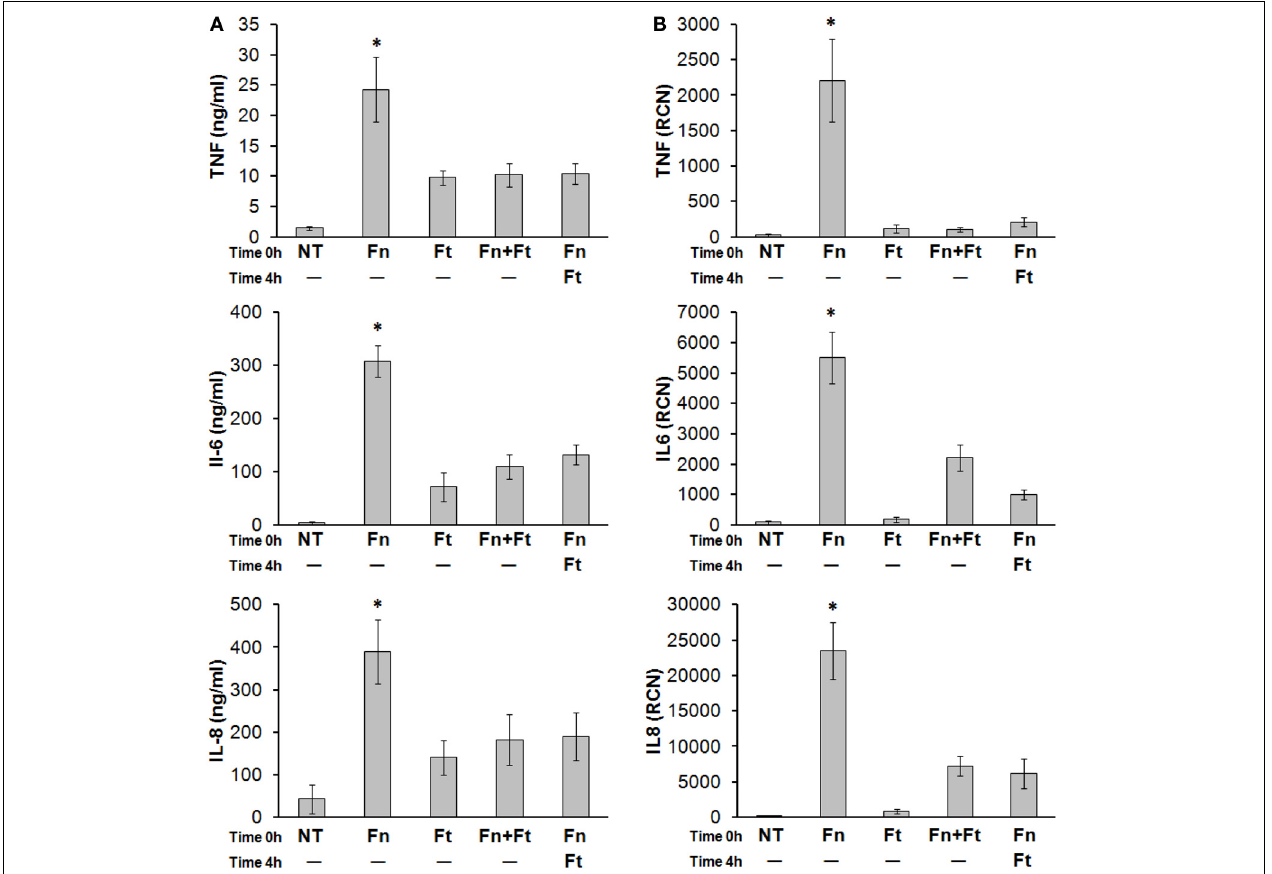
FIGURE 6 | F. tularensis administered after F. novicida infection can still suppress the pro-inflammatory cytokine response elicited by F. novicida . Primary human monocytes were left untreated (NT) or infected overnight (16h) with F. novicida (Fn), F. tularensis (Ft), or both at an MOI of 50 for each bacteria. In other samples, F. tularensis infection was performed 4h following